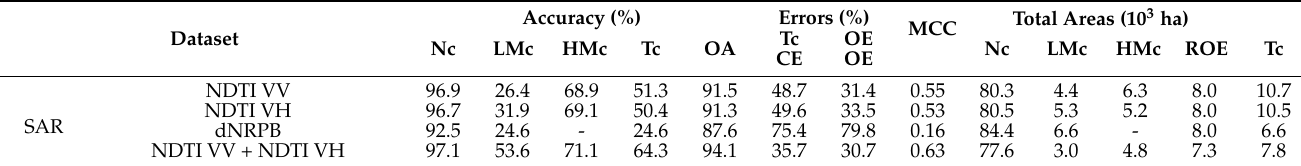
Table 9. Summary of the confusion matrix parameters and Matthews Correlation Coefficient (MCC) obtained for the Richmond flood, in comparison to the Reference Observed Event (ROE) (Nc—No changes; LMc—low-magnitude changes; HMc—high-magnitude changes; Tc—total changes;